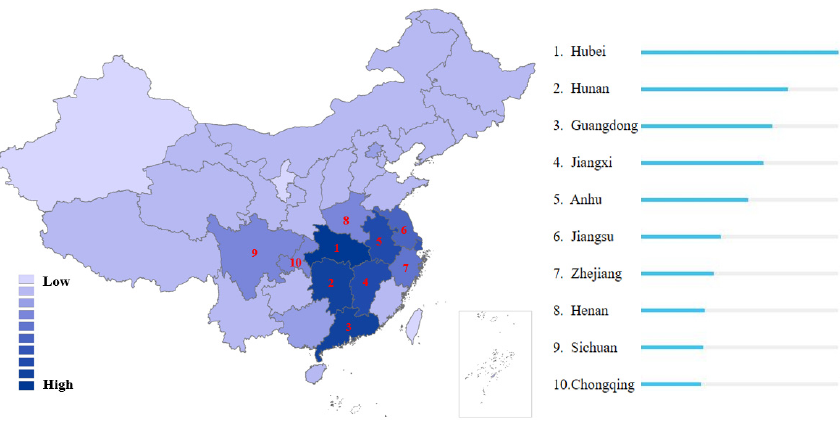
Figure 1. Attention paid to ratoon rice in different provinces in China.